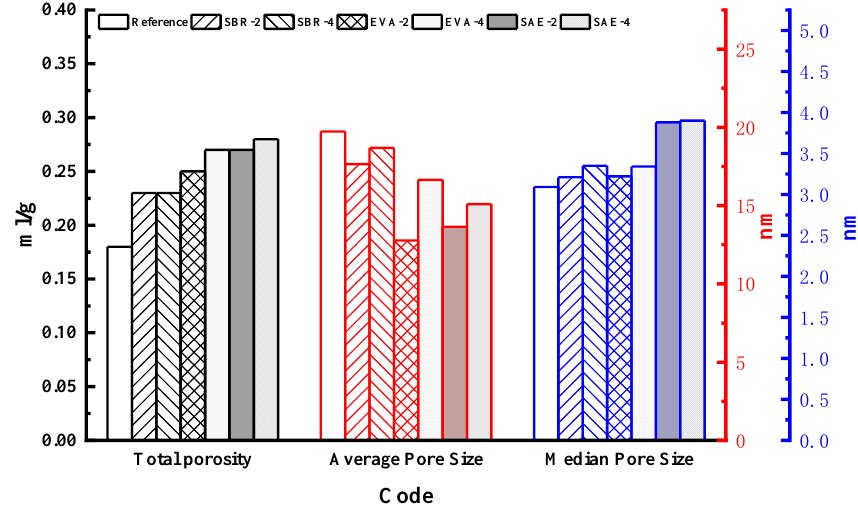
Figure 4. Porosity and characteristic porosity parameters of paste samples at 28 days.